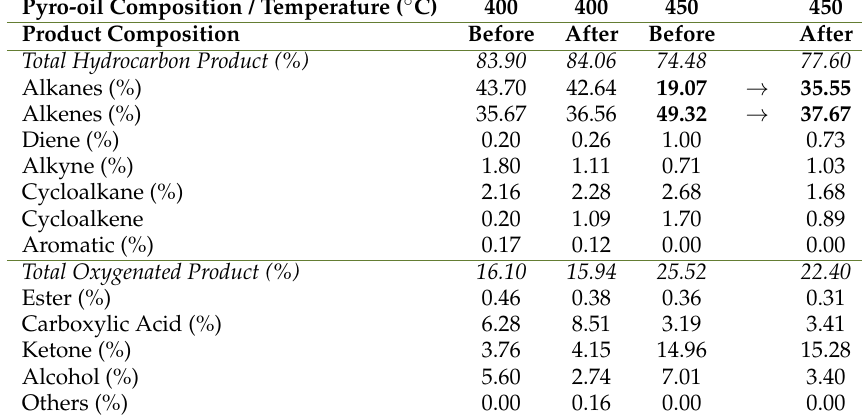
Table 2. Composition of pyro-oil at different temperature before and after second fractional